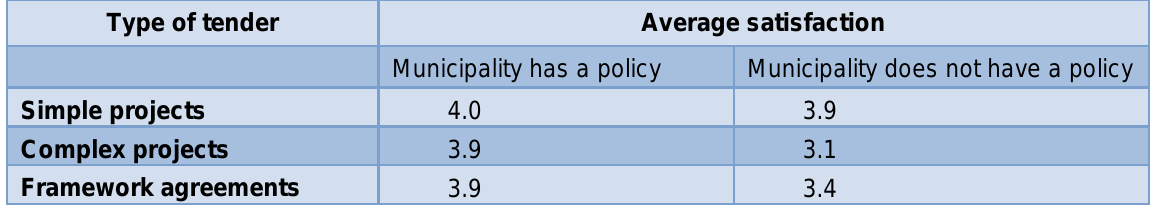
Table 10 Resp ondent‟s view of current procurement procedures (five -degree scale, where 1 = bad, 5 = very good) compared with the existence of a procurement